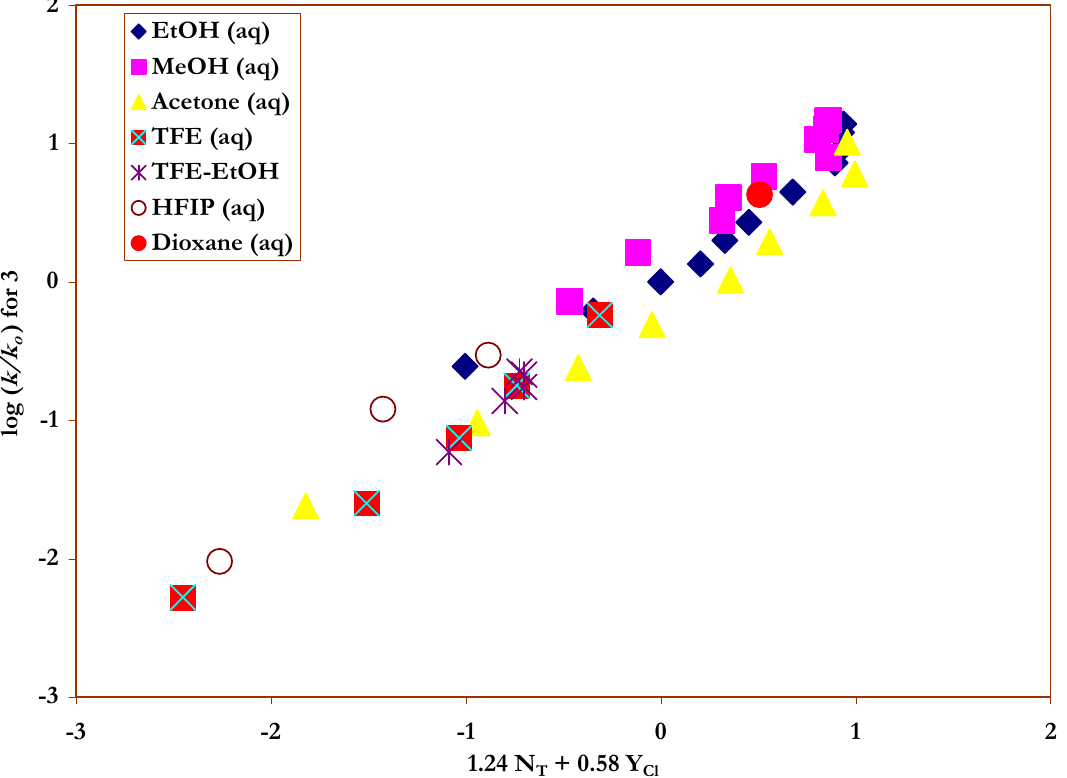
Figure 4. The plot of log ( k/k styrenesulfonyl chloride ( 3 ) in pure and binary solvents at 45.0